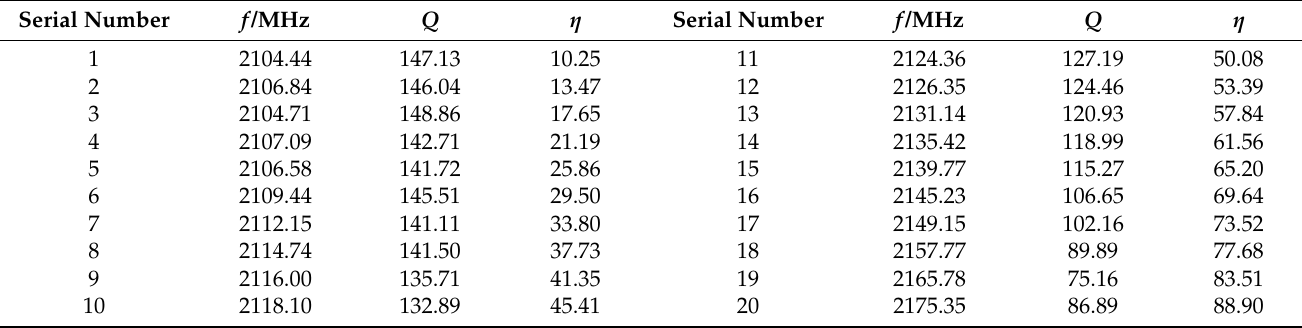
Table 2. Samples of experimental